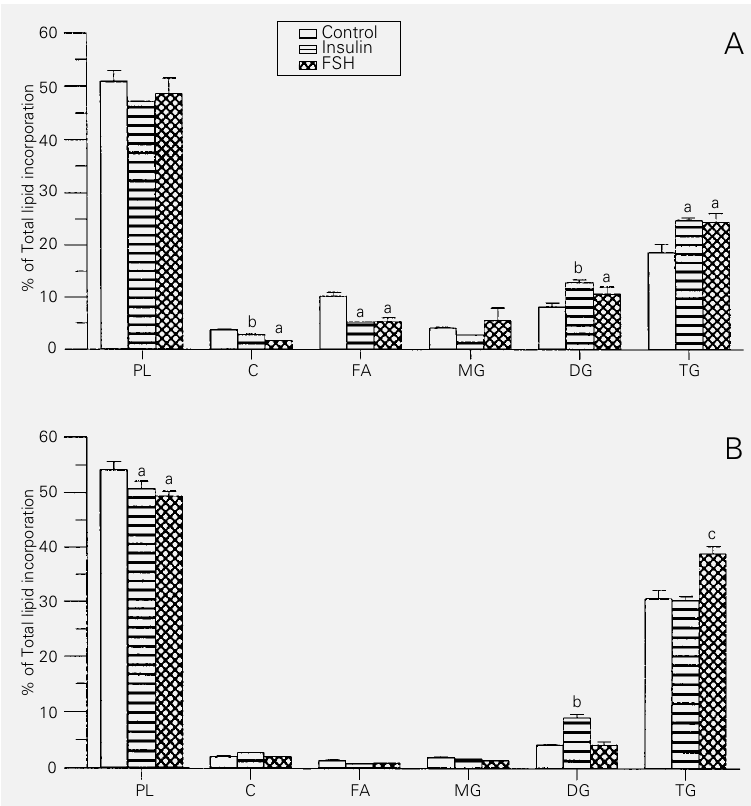
Figure 1- Effects of FSH and insulin on [1,2- 14 C]acetate incorporation into classes of lipids of Sertoli cells. Sertoli cells were pretreated for 16 h with 100 ng/ml FSH or 5 (cid:181)g/ml insulin and incubated for 90 min with 1 (cid:181)Ci/ml and for 360 min with 0.5 (cid:181)Ci/ml [1,2- 14 C]acetate. A , 90 min of acetate treatment; B , 360 min of acetate treatment. Data are reported as the mean – SEM of 6 determinations. a P<0.05 compared to control; b P<0.05 compared to control and FSH; c P<0.05 compared to control and insulin. (Newman-Keuls test). PL, Phospholipids; C, cholesterol; FA, fatty acids; MG, monoglycerides; DG, diglycerides; TG,